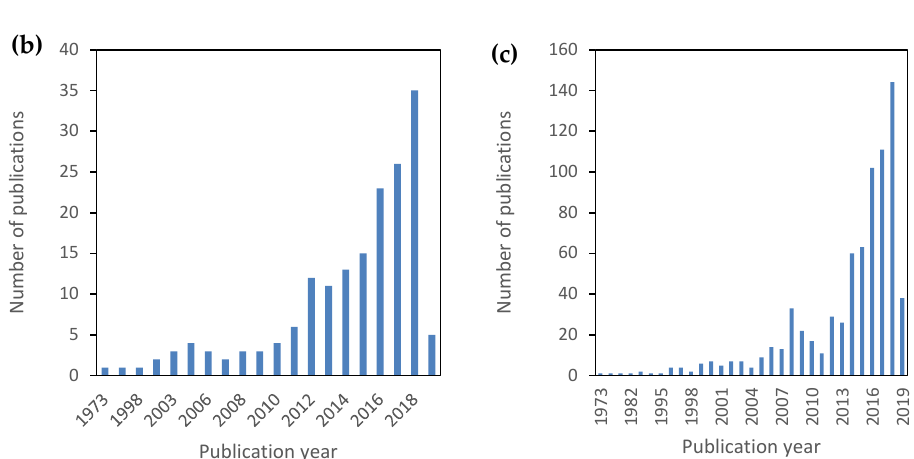
1930 1935 1938 1940 1943 1953 1960 1962 1966 1970 1973 1975 1977 1979 1981 1983 1985 1987 1989 1991 1993 1995 1997 1999 2001 2003 2005 2007 2009 2011 2013 2015 2017 2019